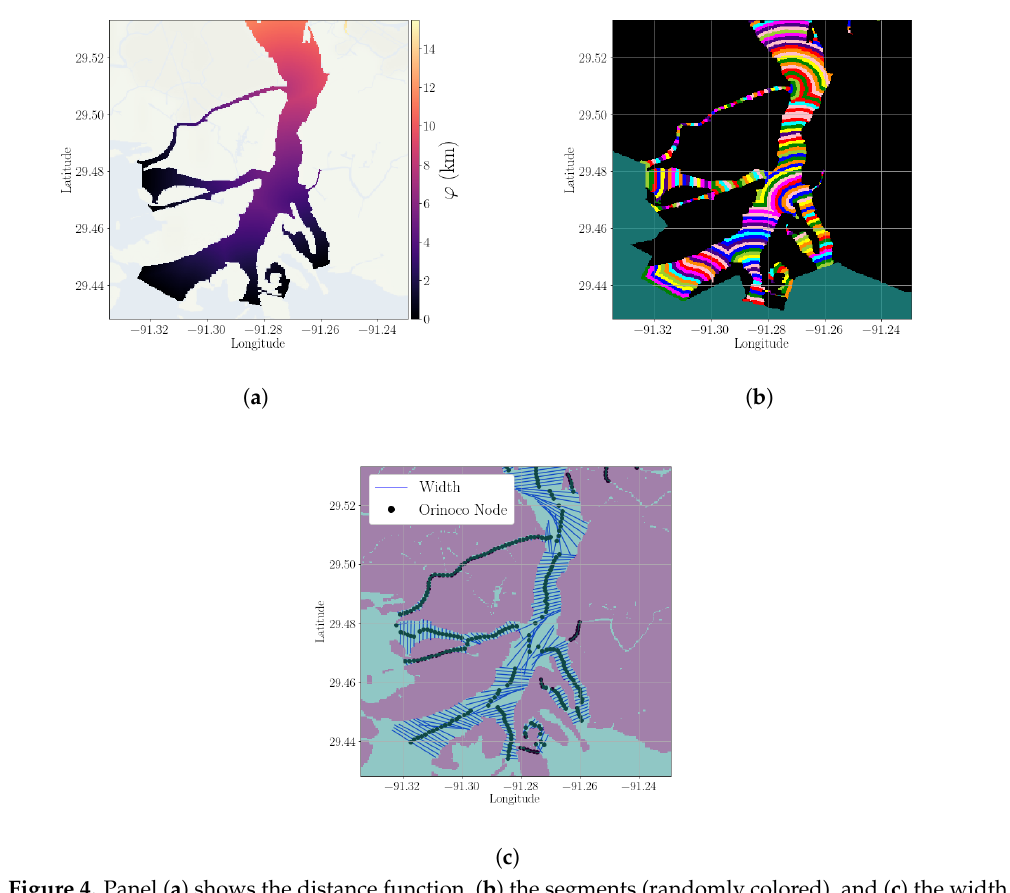
Figure 4. Panel ( a ) shows the distance function, ( b ) the segments (randomly colored), and ( c ) the width along and associated orientation over a subset of the Atchafalaya Delta using the OSM-derived water mask shown in Figure 2. The black dots in panel ( c ) are the network’s nodes. We note the width’s geometry should be approximately perpendicular to the front of the segment it belongs to as this will be parallel to ∇ ϕ